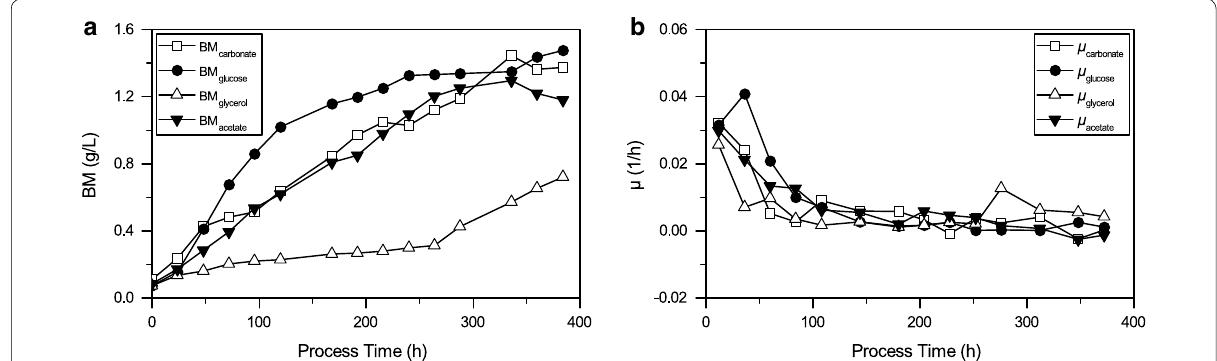
Fig. 1 a Growth curves and b average specific growth rates of Synechocystis sp. PCC 6714 on 5 mM carbonate, acetate, glucose, and glycerol ( BM biomass). The values shown are the mean of three individual experiments, a single standard deviation is given as error